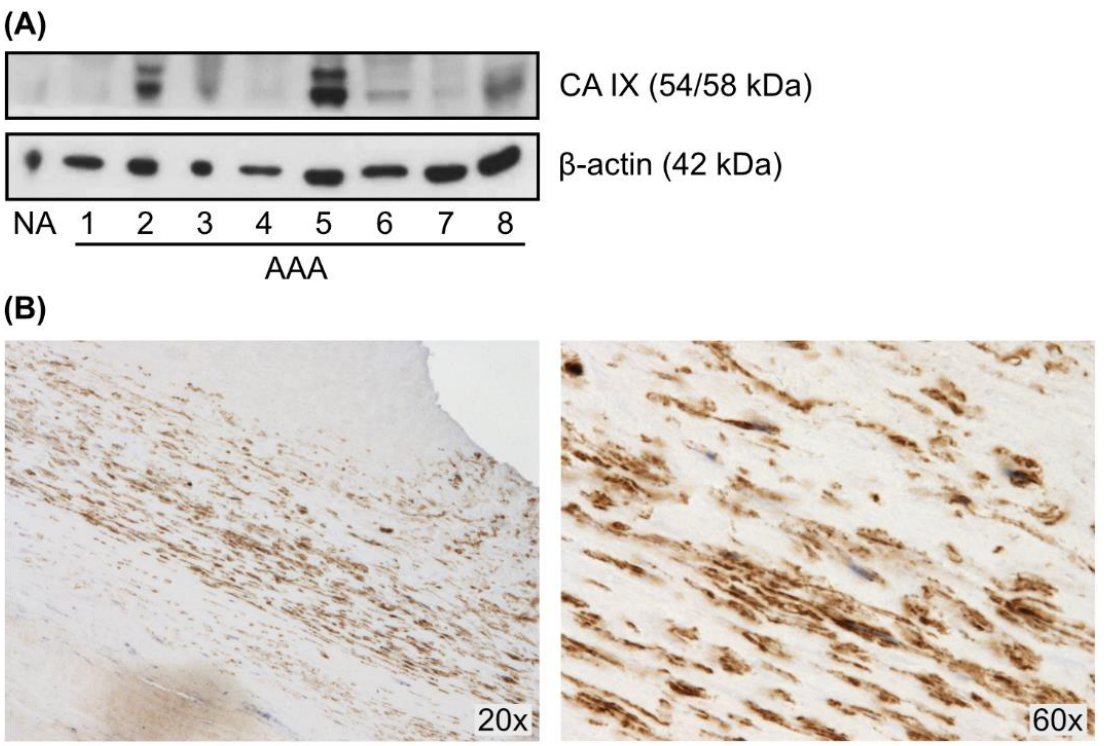
Figure 1. Representative western blot of CA IX protein expression in human AAA tissues. ( A )